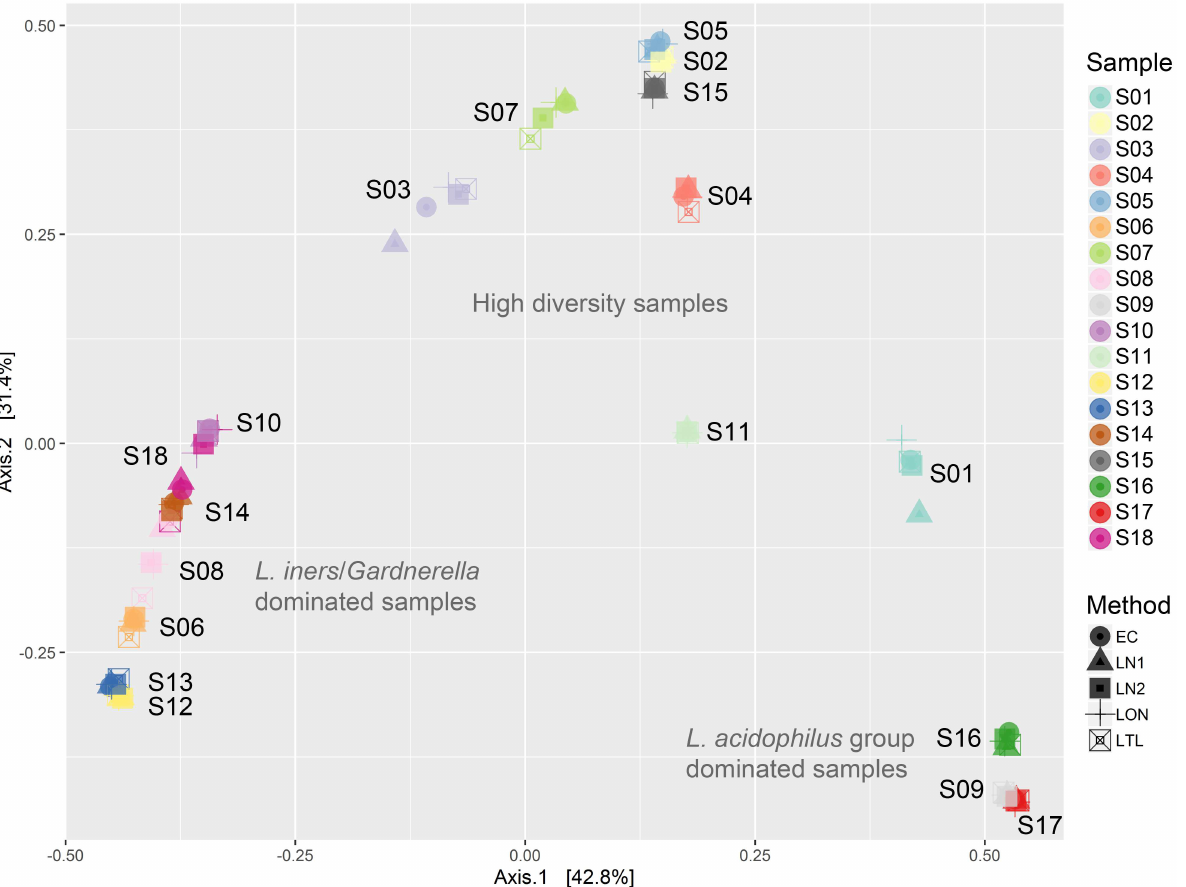
Fig 4. Principalcoordinateanalysis ordinationof a Bray-Curtis dissimilaritymatrix. Extracts are colouredby sampleof origin. Extracts clusterclosely with otherextracts originatingfromthe same sampleand thereis no observable effect of pretreatment lysis method. Extracts fromsamples that are dominatedby Lactobacillusiners with variable proportionsof Gardnerella have clusteredon the left,extracts fromsamples that are dominatedby L . acidophilus group have clusteredon the bottomrightand extracts fromhigh diversity samples that containeda mixtureof strictand facultative anaerobescluster towards the top.